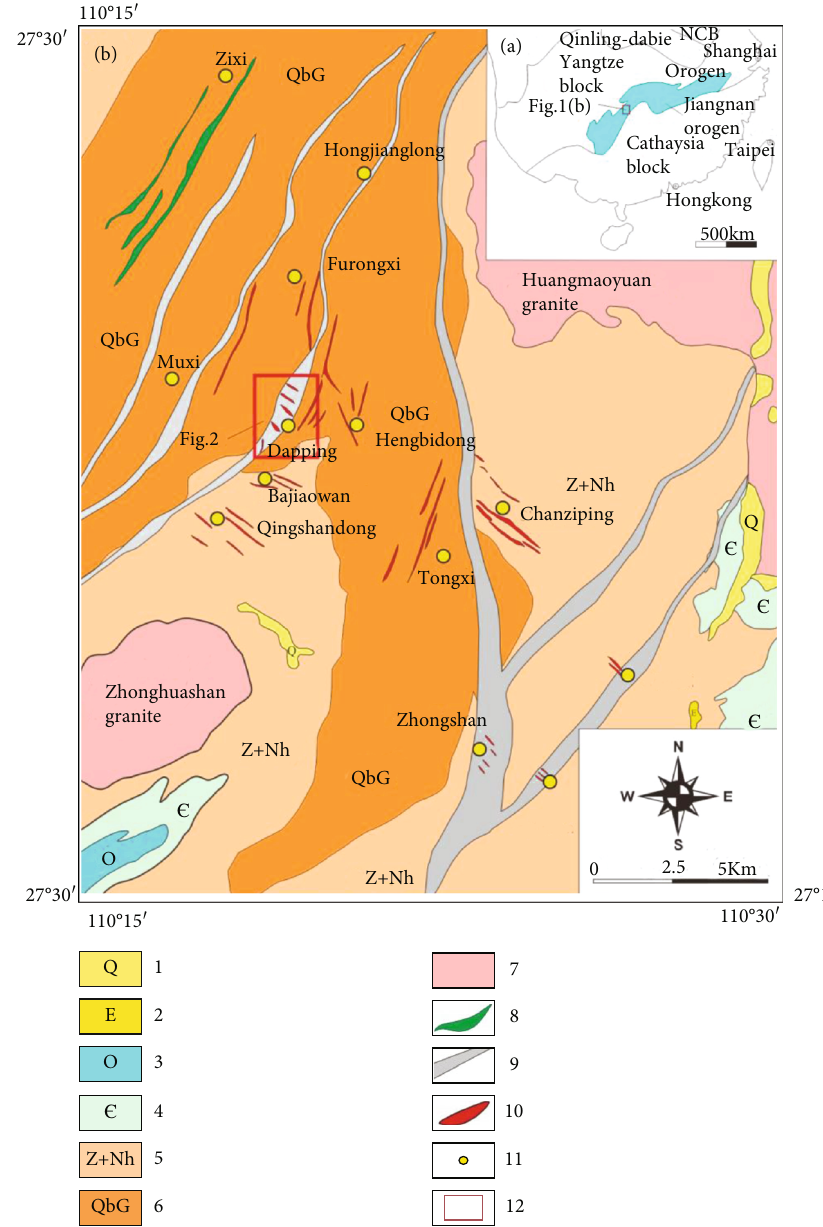
Figure 1: (a) Major tectonic blocks of China. (b) Regional geological sketch map of the middle Xuefeng Mountain (modi fi ed after [6 – 8]): 1: Quaternary (Q); 2: Palaeogene (E); 3: Ordovician (O); 4: Cambrian ( Є ); 5: Sinian and Nanhuan (Z+Nh); 6: Gaojian Group (QbG); 7: Early Triassic granite rocks; 8: Ma fi c-ultrama fi c rocks; 9: shear zone; 10: auriferous vein; 11: gold occurring spot; 12: study